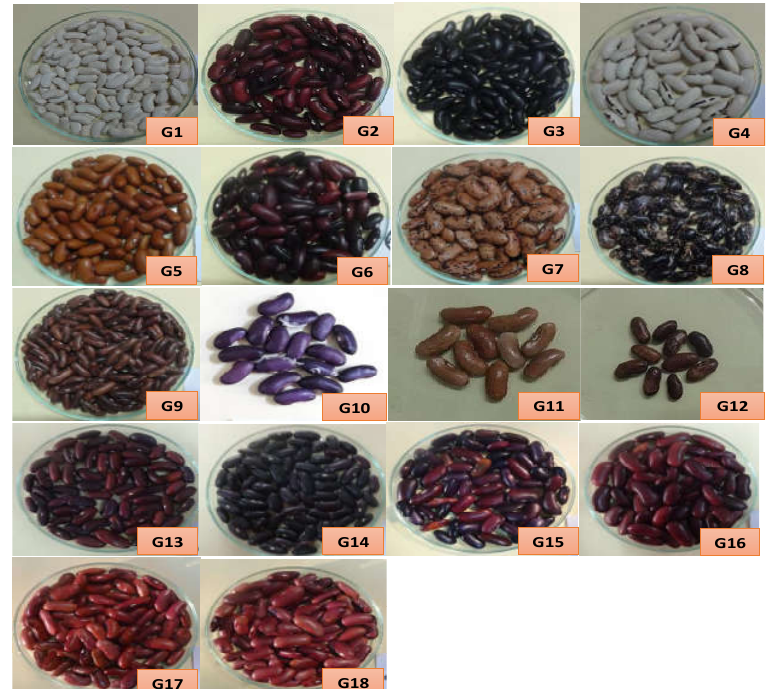
Fig. 1. Variation in seed color, shape, and size in kidney bean